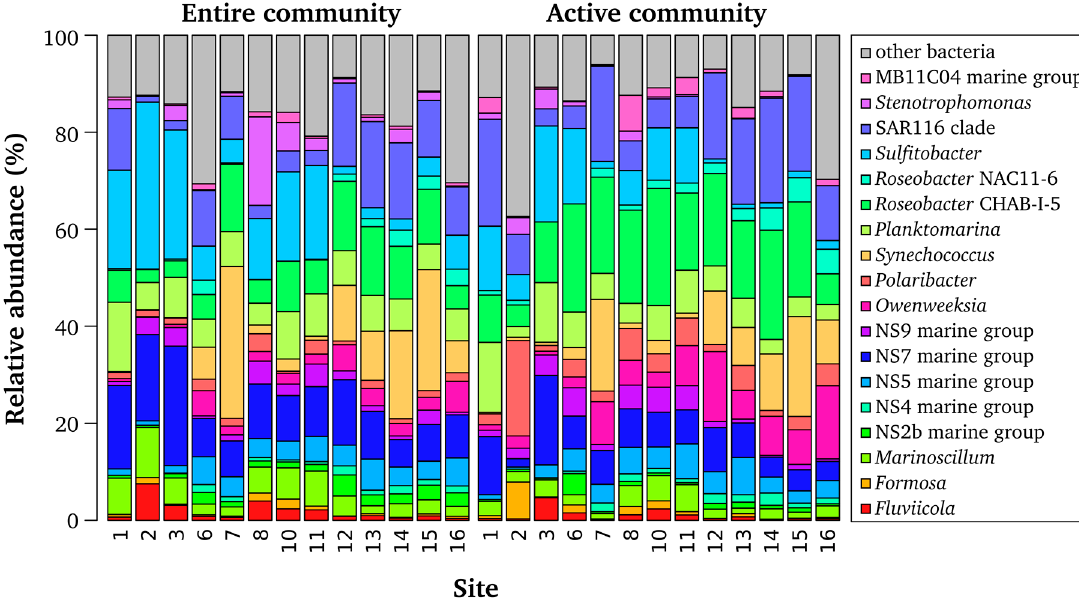
Figure 3. Observed composition of the entire and active bacterioplankton communities. Only genera and marine lineages with an average abundance of more than 1% are shown.